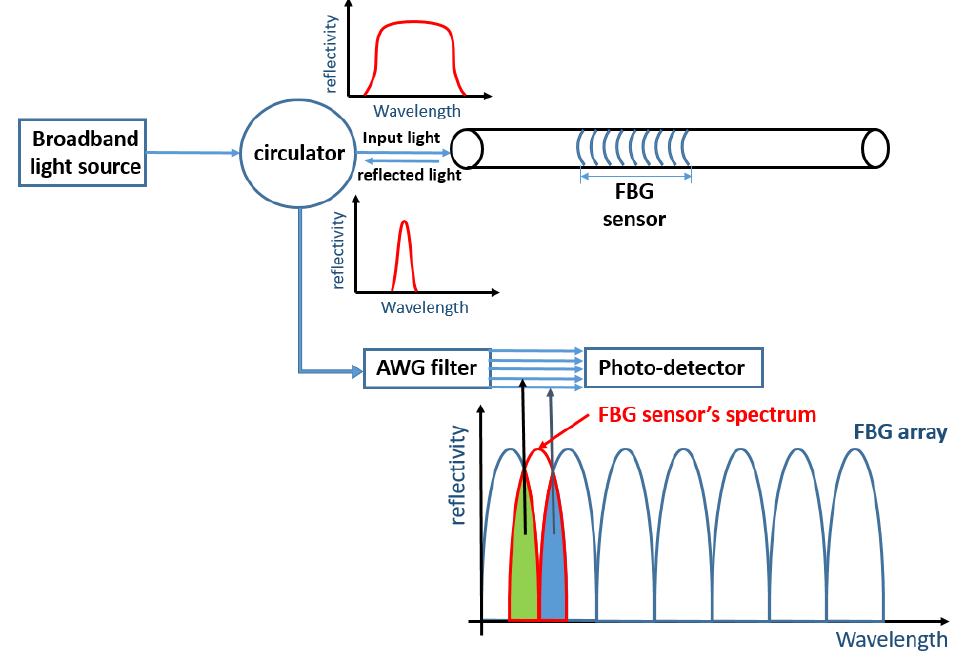
Figure 1. Principle of a power detection demodulation method [14].